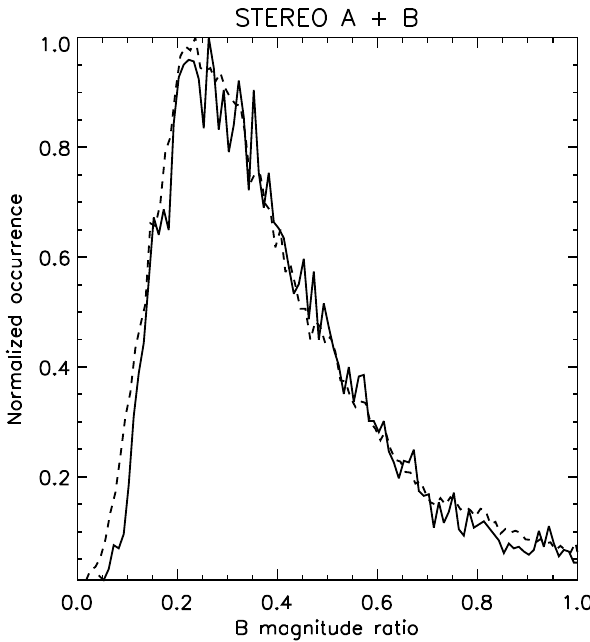
Fig. 9. Occurrence distributions of the ratio of the local magnetic field strength to that at the nearby SI for times of CSE (solid lines) and all data (dashed lines). The magnetic field at the nearby SI (Ta- ble 2) is determined as the strongest field in a ± 2h interval around the SI. During times of CSE, the distribution is not statistically dif- ferent from that for all